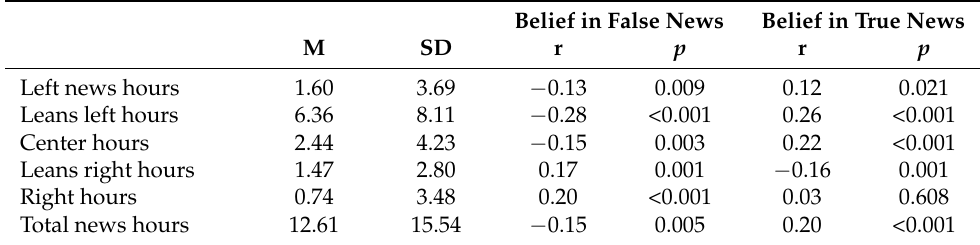
Table 3. Means, standard deviations and correlations with belief in false election news for the number of hours of election news consumed for each political leaning of news sources. Belief in False News Belief in True News M SD r p r